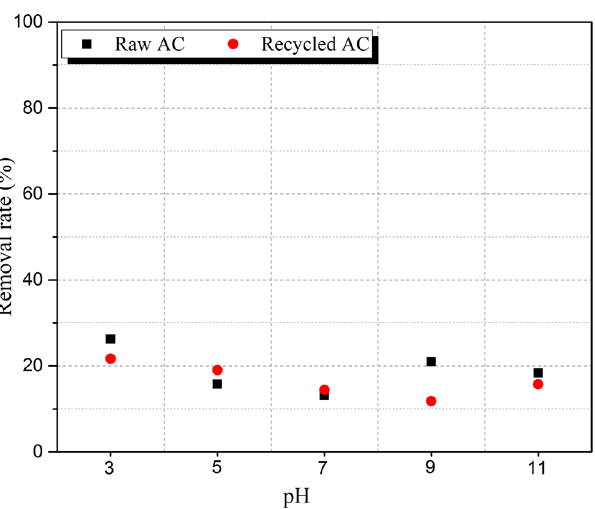
Figure 11. Aqueous equilibrium adsorption test results for raw and recycled AC